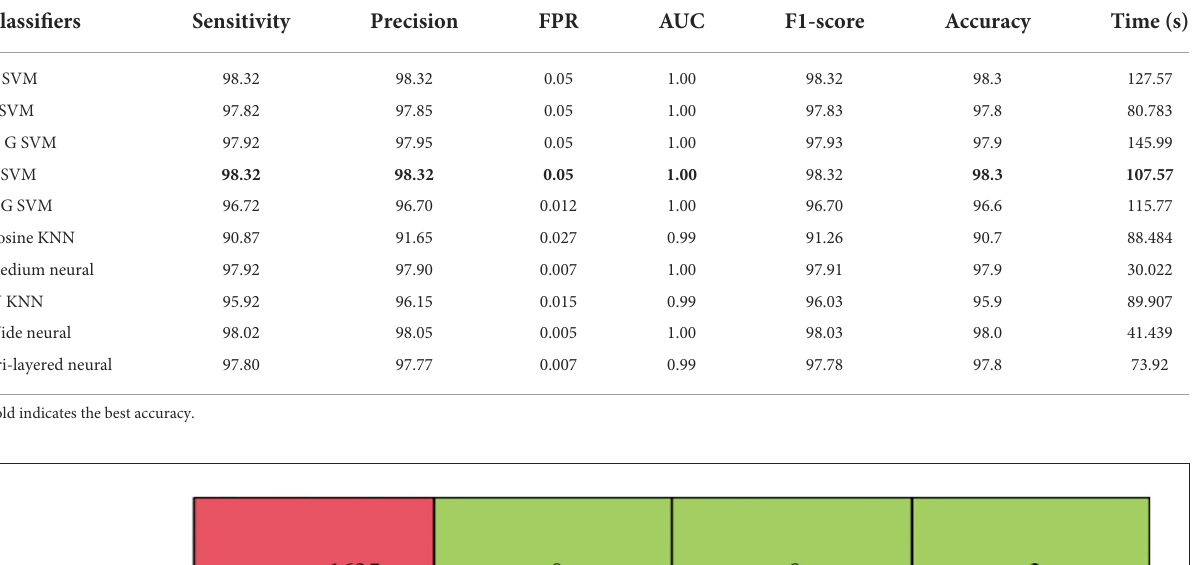
30.022 s for the Medium Neural classifier, whereas the maximum noted time is 145.99 (s) for the